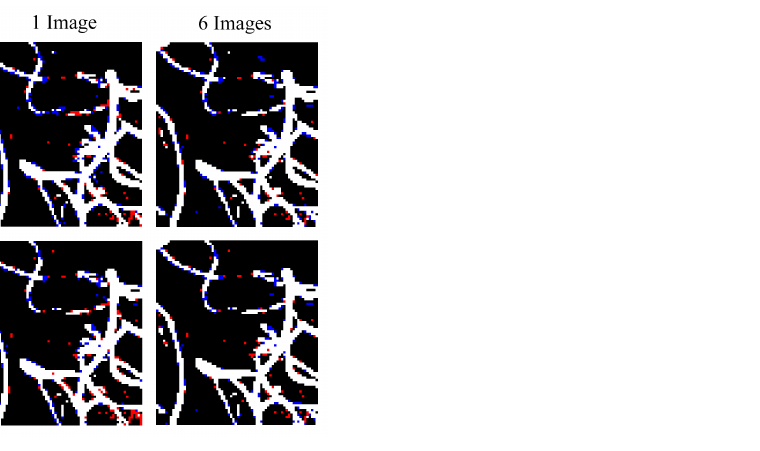
Figure 6. Qualitative comparison of models trained with one volume and six volumes, for U-Net MSS with and without deformation-aware learning. Red indicates false negative and blue indicates false positive. Table 3. Resultant Dice coefficients while comparing different methods against a manually seg- mented region.